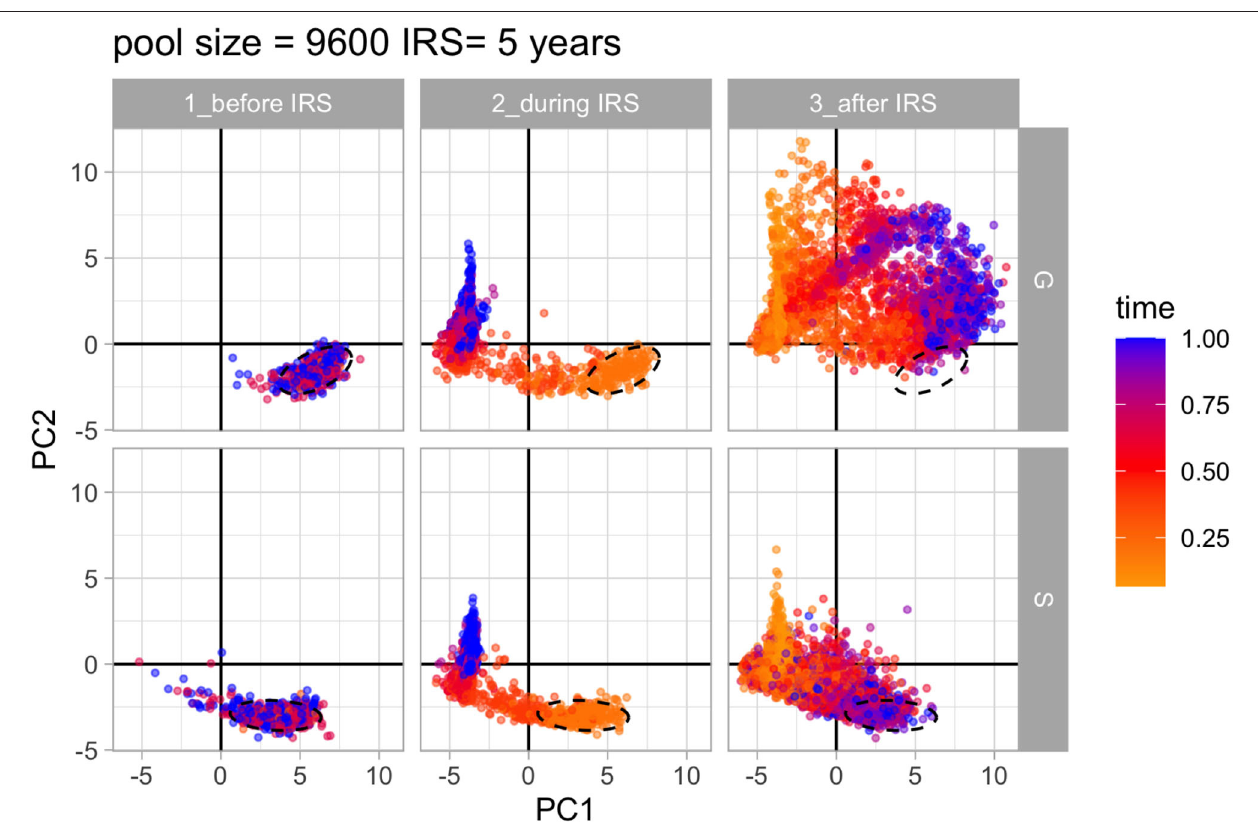
FIGURE 6 | Principal component analysis of 37 network properties of var repertoire similarity networks. PCA over time shows how the structure of diversity changes in the 2D space of the PCs for S and G under high transmission. The colors of the networks represent their relative time within the specific time period (i.e., before, during and after IRS) in the simulation. Ellipses show the location of network properties for pre-IRS layers. Parameters: gene pool size equals 9,600 and IRS lasts for 5 years.